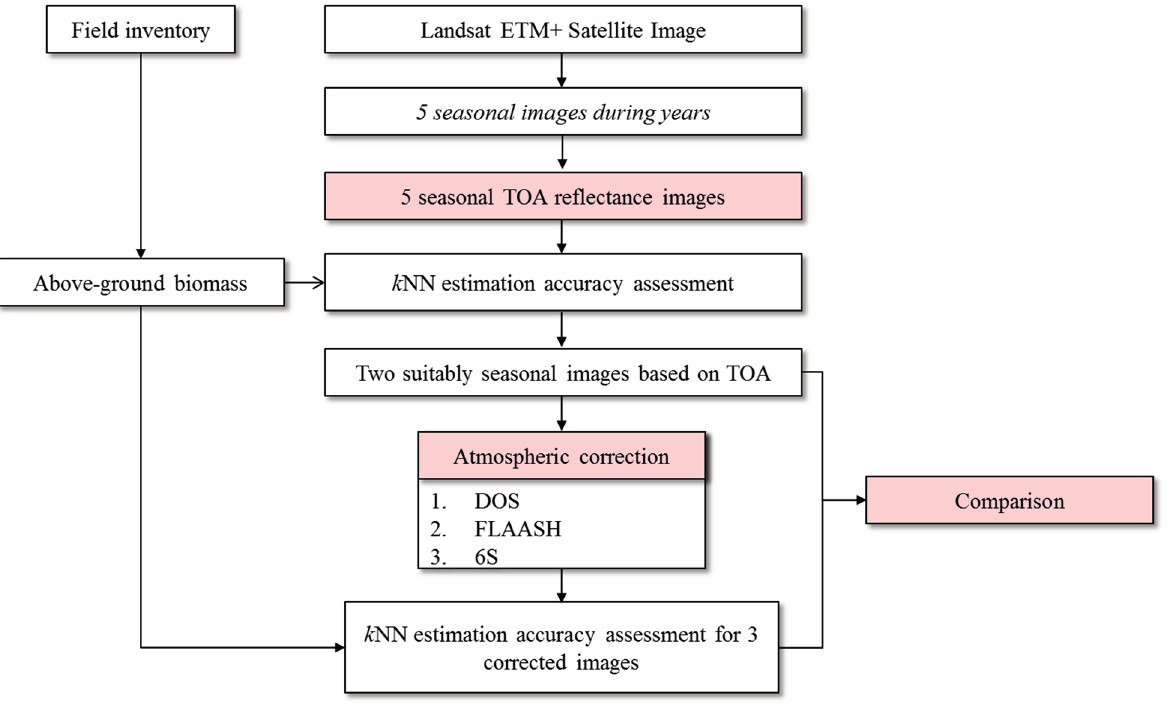
Figure 3. Study flow